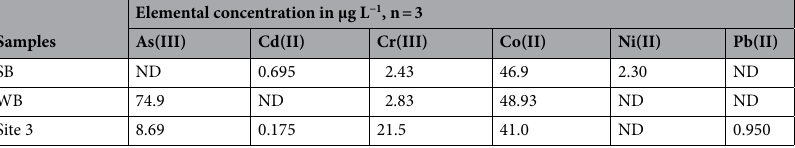
Table 6. Recoveries of As(III), Cd(II), Cr(III), Co(II), Ni(II) and Pb(II) ions from AMD water samples using the proposed UASPME/ICP-OES method, n = 3.